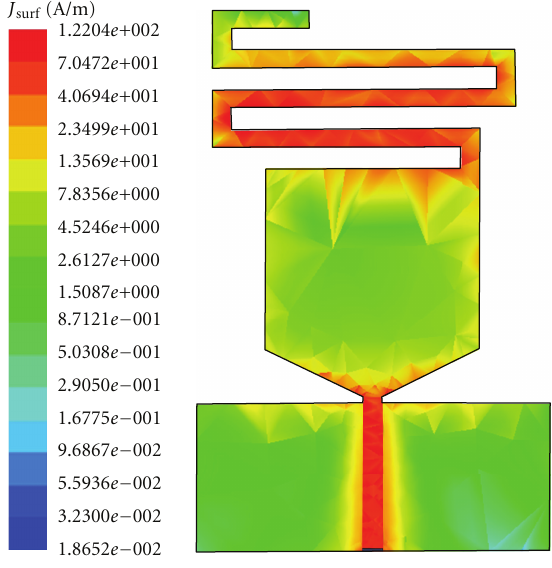
Figure 3: Current distribution at 750MHz.